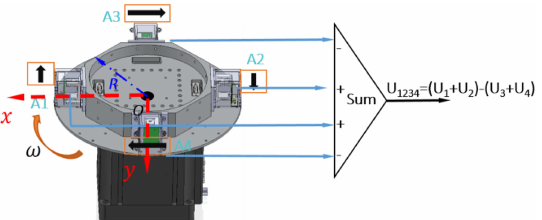
Figure 1. Schematic diagram of the mechanical modulation of the